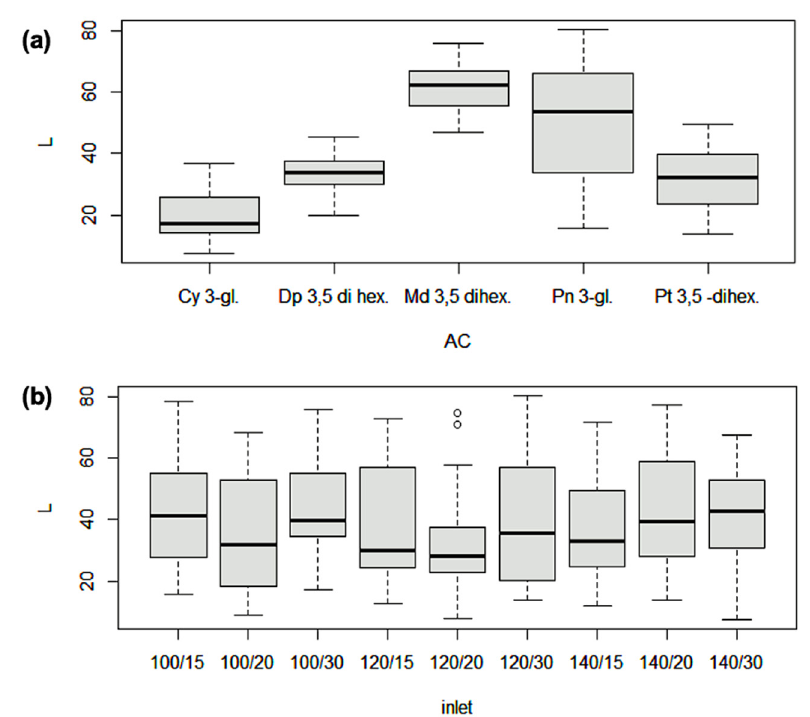
Figure 3. Anthocyanin losses (%) from spray dried microcapsules of calafate (L) in ( a ) individual anthocyanins; ( b ) comparison of total anthocyanin losses, considering all treatments (tempera- ture/percentage of maltodextrin).